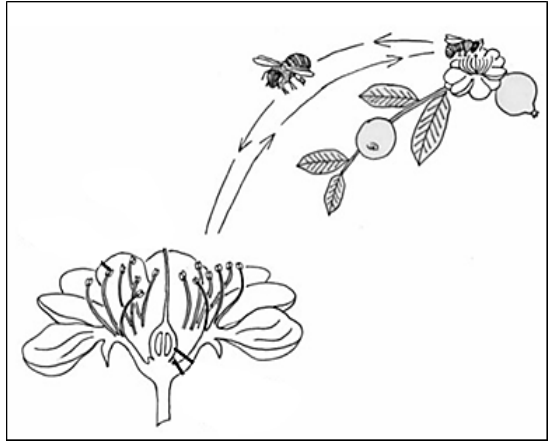
Figure 3. Reproduction method by pollination.